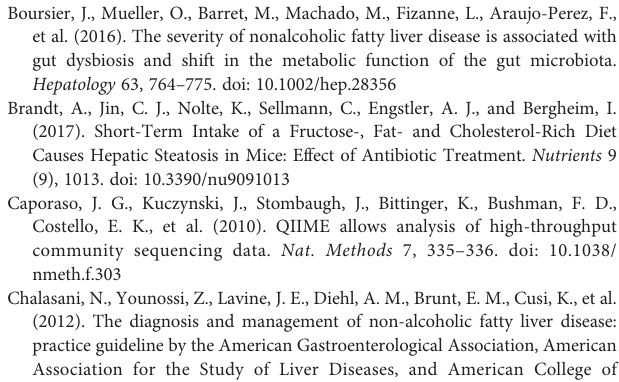
SUPPLEMENTARY FIGURE 1 | Isolation and whole-genome sequencing of clinical Escherichia strains from the intestinal mucosa of NASH patients. (A) Comparison of the seven genera abundance among NASH and NAFLD patients and healthy subjects. (B) Schematic diagram of the overall design and bacterial isolation . (C) Two representative liver H&E images of NASH patients (blue arrows, in fl ammatory cells; red arrows, steatosis). (D) Negative immunostaining for HBsAg and HBcAg in the NASH patient. (E) Representative image of Escherichia strains on E. coli Chromogenic Medium. (F) Phylogenetic relationships among clinical E. coli strains inferred with the maximum likelihood method based on the full-length 16S rRNA sequence. The black scale bar indicates 100 m m and 50 m m. Data are calculated as the mean ± SEM, n = 9 – 10 per group. *p <0.05, **p <0.01 (one-way analysis of variance between multiple groups). SUPPLEMENTARY FIGURE 2 | General functional annotations of E. coli NF73-1 andbodyweightofmouse. (A) KEGGgeneralfunctionalannotationsof E.coli NF73-1. (B) Body weight of mouse. Data are calculated as the mean ± SEM, n = 5 per group. *p <0.05, **p <0.01 (one-way analysis of variance between multiple groups). SUPPLEMENTARY FIGURE 3 | Total bacteria in stool samples with administration of antibiotics in NAFLD mice and the generation of E. coli EGFP- NF73-1. (A) Total bacterial loads in stool samples of NAFLD mice and ND mice treated with antibiotics were determined from the DNA concentrations. Data are calculated as the mean ± SEM, n = 4 – 6 per group. **p <0.01 (one-way analysis of variance between multiple groups). (B) Representative image of EGFP expression of E. coli EGFP-NF73-1 and E. coli EGFP-MG 1655 strains and the positive control. (C) Flow cytometry gating strategies for liver macrophages. Representative fl ow cytometric plots. (D) Flow cytometry gating strategies for liver lymphocytes. Representative fl ow cytometric plots; (E) Flow cytometry gating strategies for RAW264.7 macrophages. Representative fl ow cytometric plots. SUPPLEMENTARY FIGURE 4 | E. coli NF73-1, the non-inducer of lipid accumulation in hepatocytes in vitro . (A) The human liver normal cell line L02 and mouse liver normal cell line H2.35 were exposed to E. coli NF73-1 (multiplicity of infection = 1:10) for 4 h. (B) Lipid accumulation determined by Oil Red O staining of palmitic acid- and oleic acid-treated hepatocytes cocultured with or without E. coli NF73-1. (C) Protein synthesis of phosphorylated mTOR, S6K1, S6, SREBP-1, ACC1, FASN, and PPAR- a in palmitic acid- and oleic acid-treated hepatocytes cocultured with or without E. coli NF73-1. mTOR, mammalian target of rapamycin; S6K1, S6 kinase 1; SREBP-1, sterol-regulatory element binding proteins-1; ACC1, acetyl-coenzyme A carboxylase; FASN, fatty acid synthase; PPAR-a,